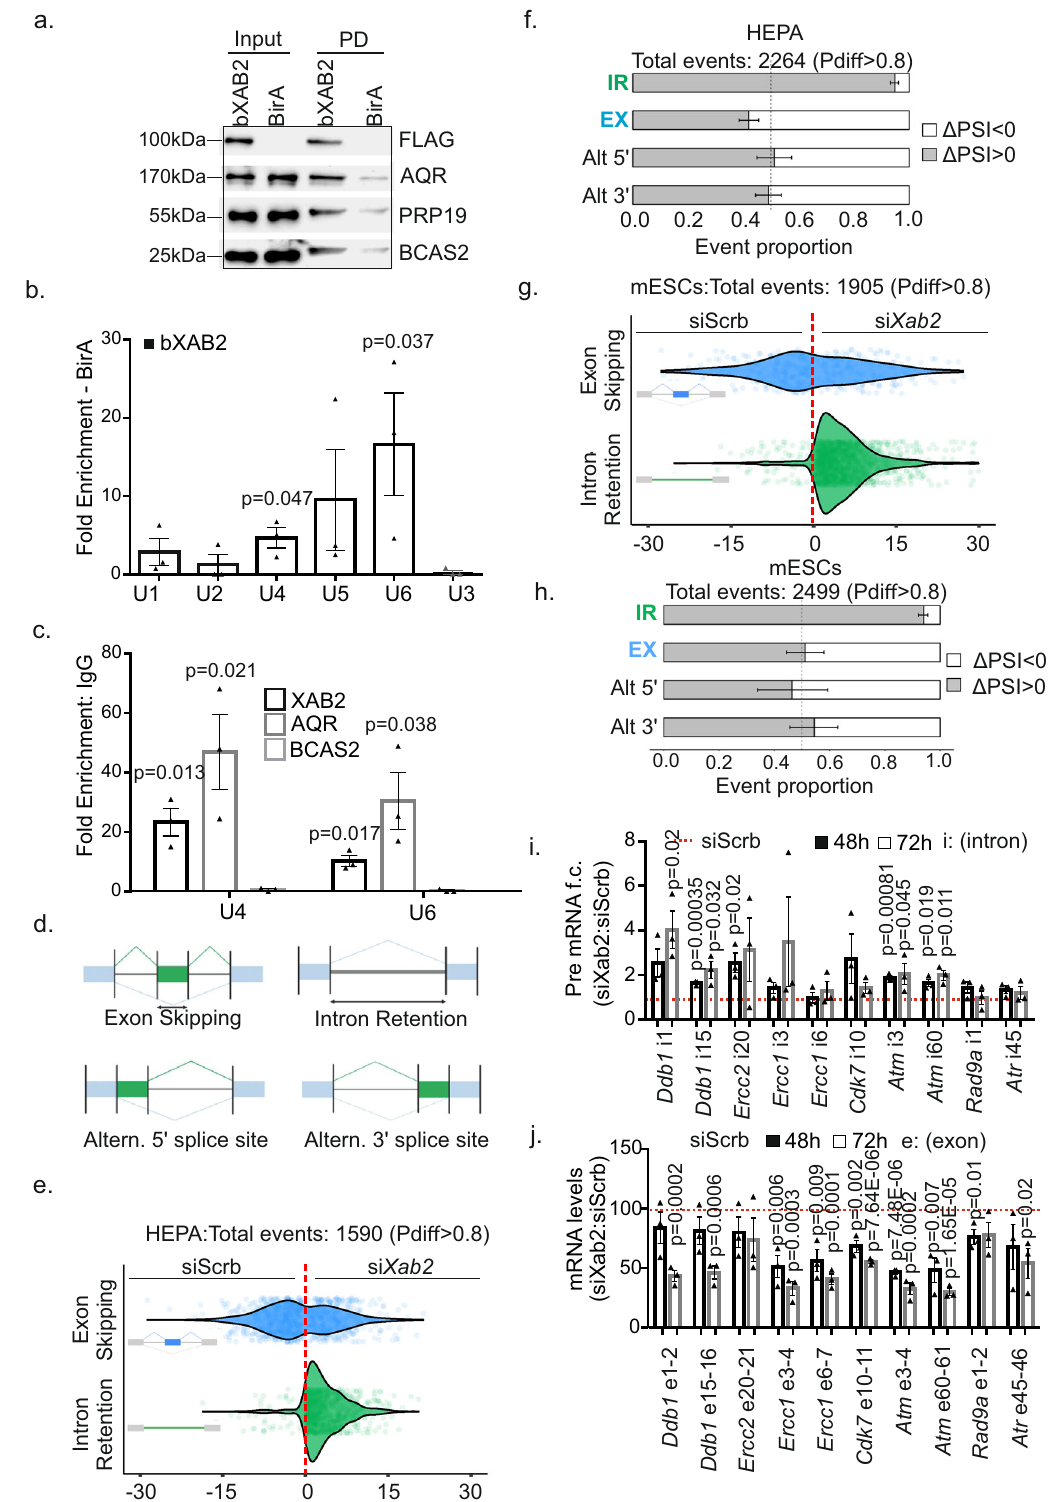
Stra6 gene but not on the coding region of the tRA non-inducible Chordc1 gene (Fig. S5D). Similar to the DNA damage-driven release of XAB2 from RNA targets (Fig. 5a, b), XAB2 ChIP sig- exposed to illudin S accumulating transcription-blocking DNA (Fig. 3a – e), we fi nd that the association of XAB2 with R-loops is